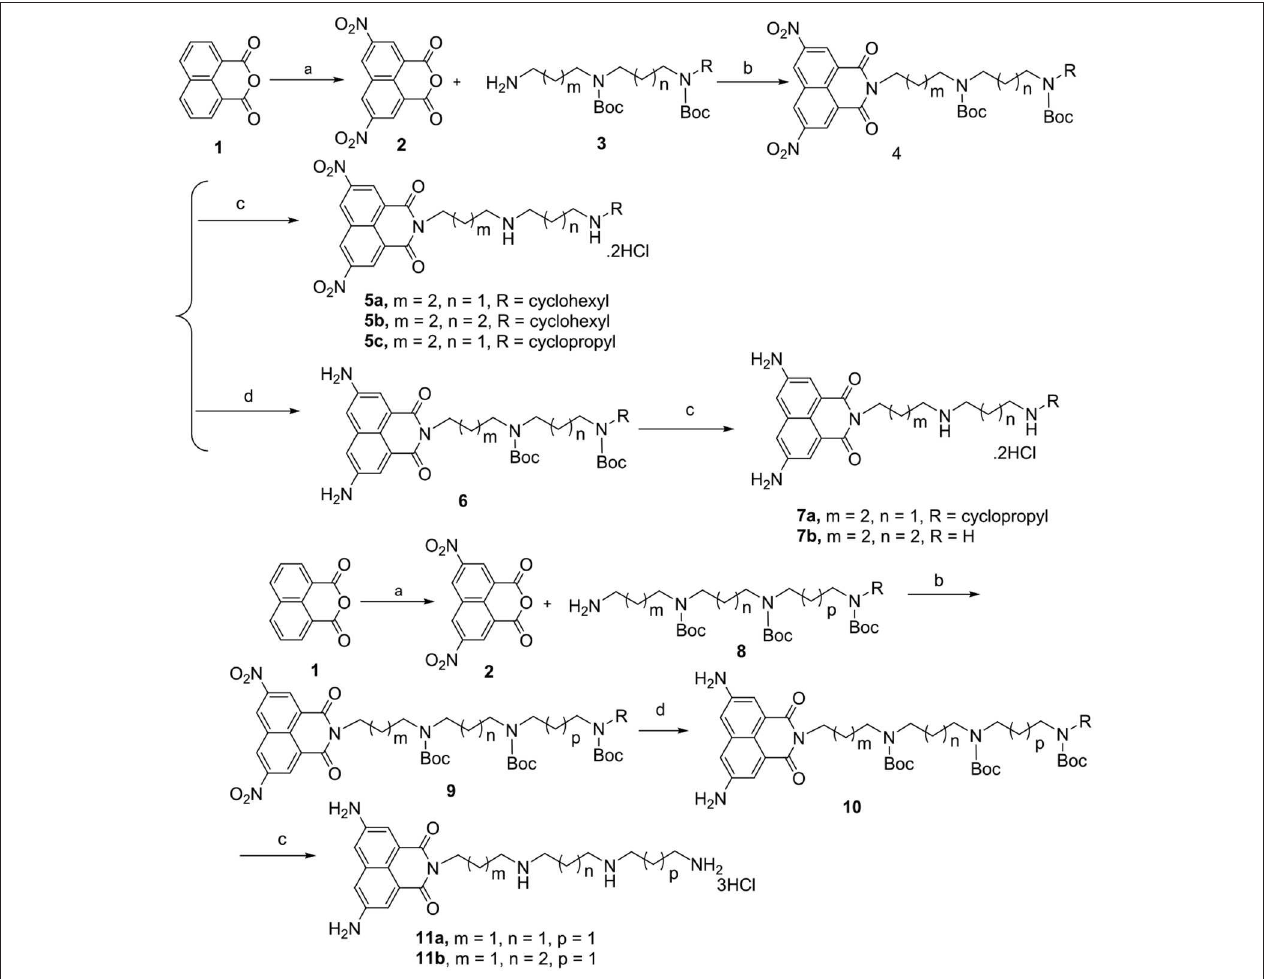
SCHEME 1 | Chemical structures and synthetic route of polyamine-based naphthalimide conjugates 5a-5c , 7a-7b , and 11a-11b in yield of 25–30%. Reagents and conditions: (a)